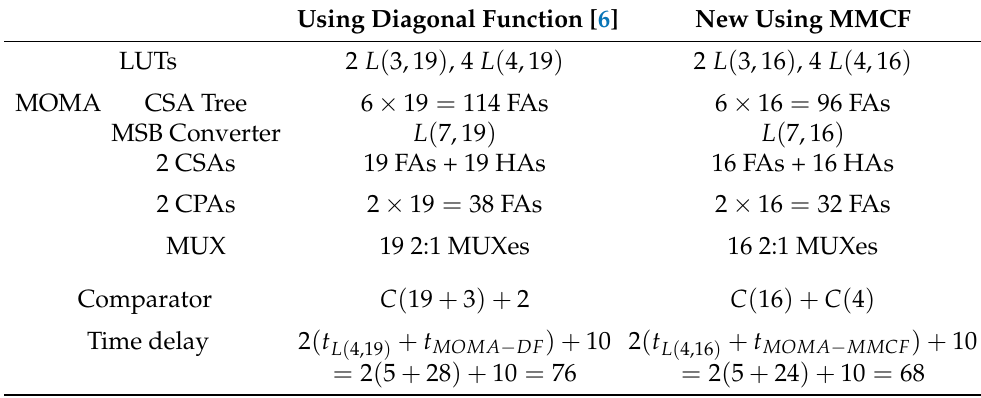
Table 5. Complexity estimation of comparators for a sample RNS S 6,1 = { 5,7,9,11,13,16 } . Using Diagonal Function [6] New Using MMCF LUTs 2 L ( 3, 19 ) , 4 L ( 4, 19 ) 2 L ( 3, 16 ) , 4 L ( 4, 16